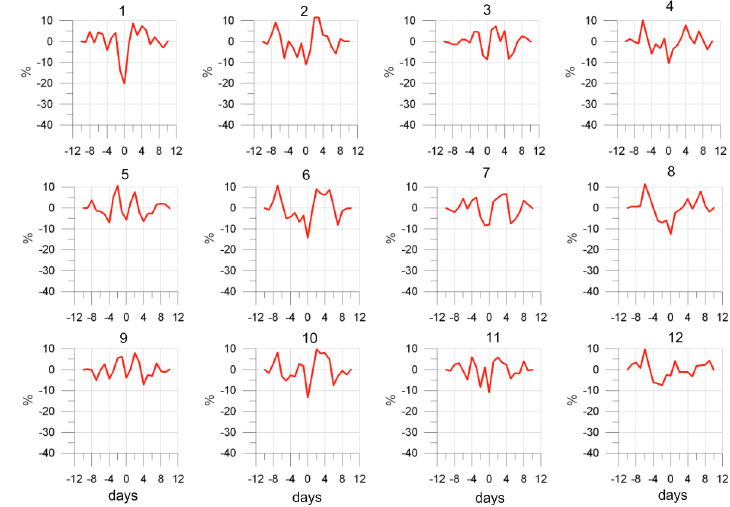
Figure 7. The same as in Fig. 6, but in the frequency range